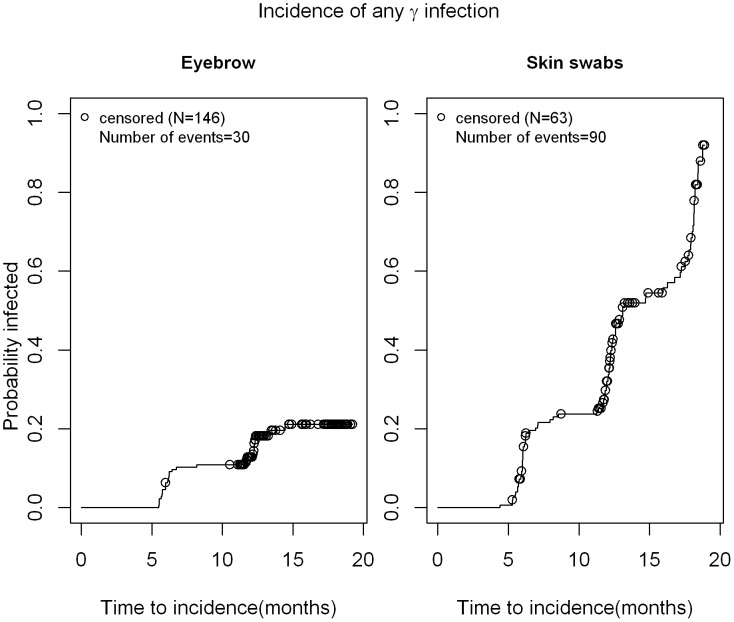
Time to incidence of γ-HPV infection in normal skin swabs and eyebrow hairs of men.Kaplan Meier estimate for time to incidence of any β HPV infection in a sample of 209 men. Participants who were negative for all HPV types at baseline were included. Time was counted until their first visit with a HPV positive sample or until censored. The 'last observation carried forward' approach was taken when counting time to incidence (e.g. 0 NA 1 pattern of HPV positivity at consecutive visits, the NA was treated as '0' and the time was counted in the time to incidence.).